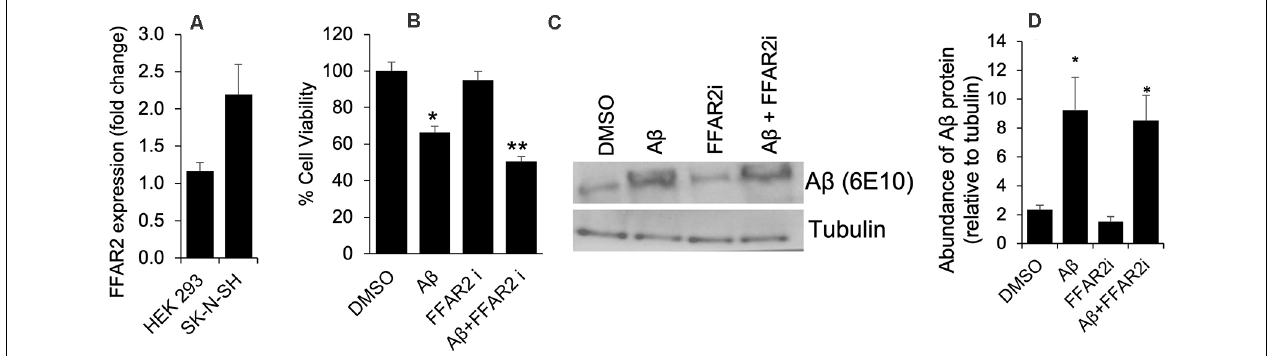
FIGURE 1 | FFAR2 expressed in human neuronal cells and its inhibition increased A β -induced neurotoxicity. (A) The mRNA expression of FFAR2 gene in SK-N-SH and HEK293 cells. (B) SK-N-SH cells treated with FFAR2i (10 µ M CATPB) for 4 h and A β 25–35 (25 µ M) for 2 h, then measured cell viability using MTT assay, show that A β -treatment induces cell death and inhibition of FFAR2 further reduced cell viability. DMSO used as vehicle control. (C,D) Similarly, A β -treatment significantly increased A β -accumulation in both with and without FFAR2 inhibition. Data are the mean ( n = 3 replicates in three repeated experiments) ± SEM. P values with * < 0.05 and ** < 0. 01 are significantly